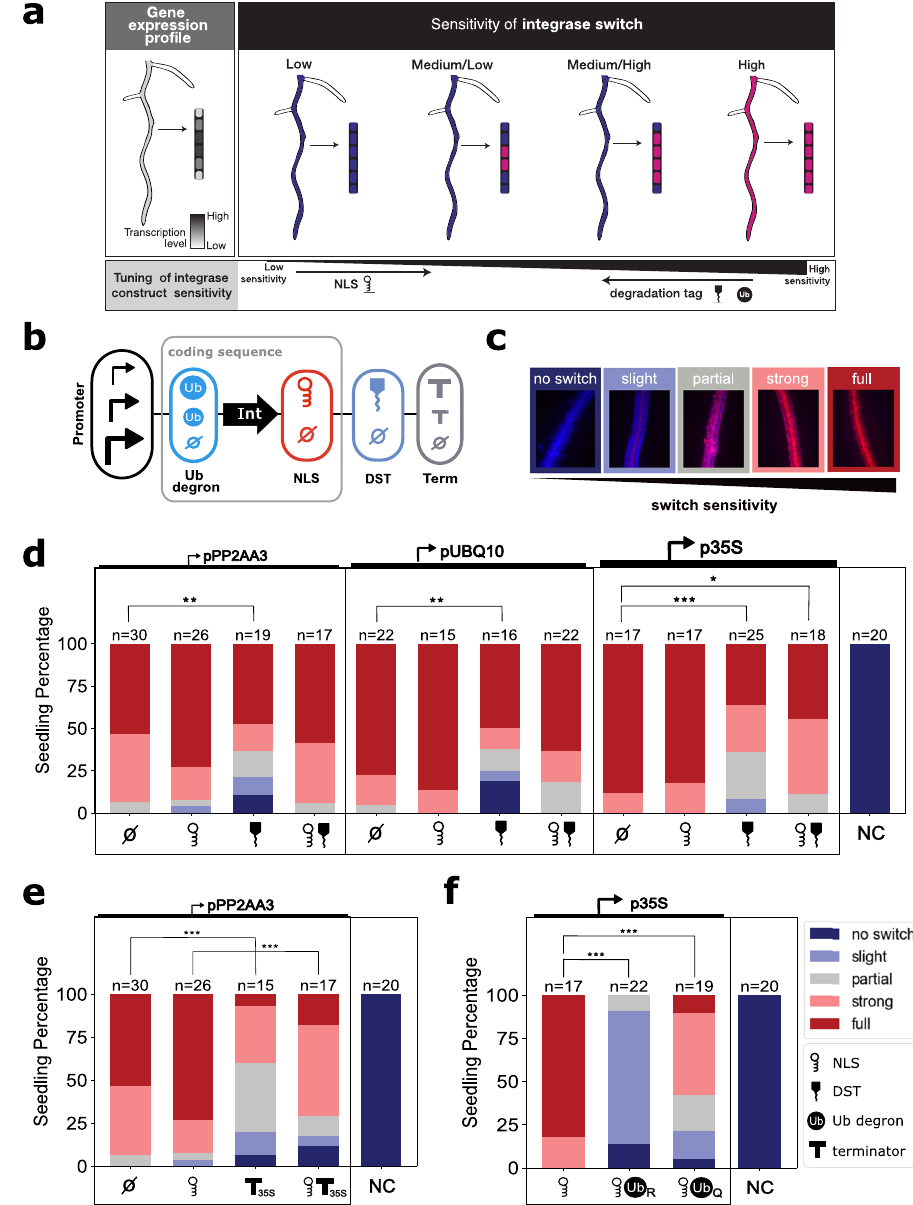
Fig. 3 | Methods for tuning integrase switch sensitivity. a For the gene expres- sion pro fi le of a given gene, a low-sensitivity integrase switch will result in little or no switching in any cells while a high-sensitivity switch will result in complete switching even in cells with relatively low expression of the gene. Different sensi- tivities of the integrase switch can lead to switches occurring at different levels of transcription. This sensitivity must betuned to achieve the desired speci fi city for a given gene expression pro fi le. b The integrase tuning constructs consist of a con- stitutive promoter controlling the integrase expression with tuning add-ons including a nuclear localization signal (NLS), RNA destabilization tag (DST), ubi- quitin (Ub) degrons, and varied terminator. c The level of sensitivity is sorted into one of fi ve categories, evaluated based on the level of mScarlet compared to